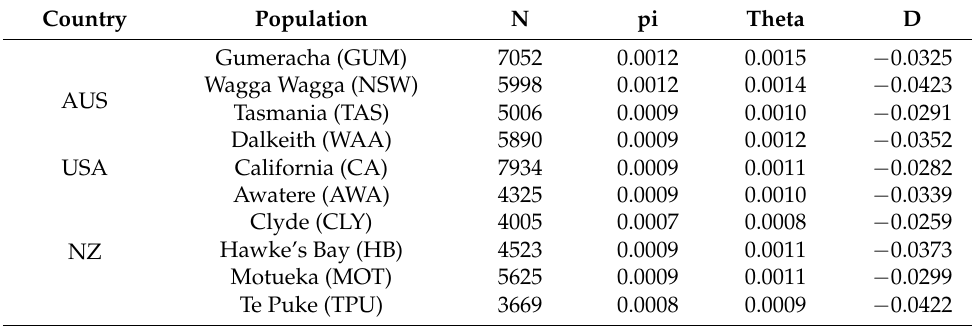
Table 4. Epiphyas postvittana population genetic parameters per